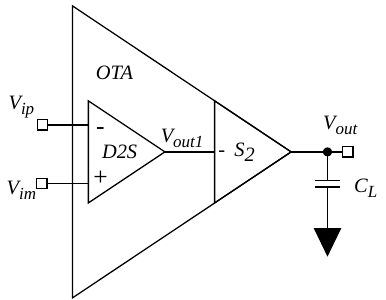
Figure 6. Architecture of the proposed ULV OTA based on enhanced D2S.